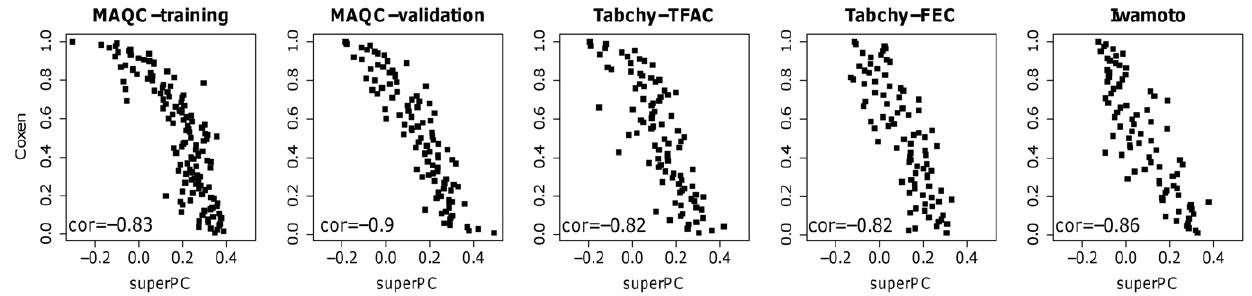
Figure 2. Correlation between the prediction scores calculated by the superPC and COXEN methods from the Neve training set for each test set.